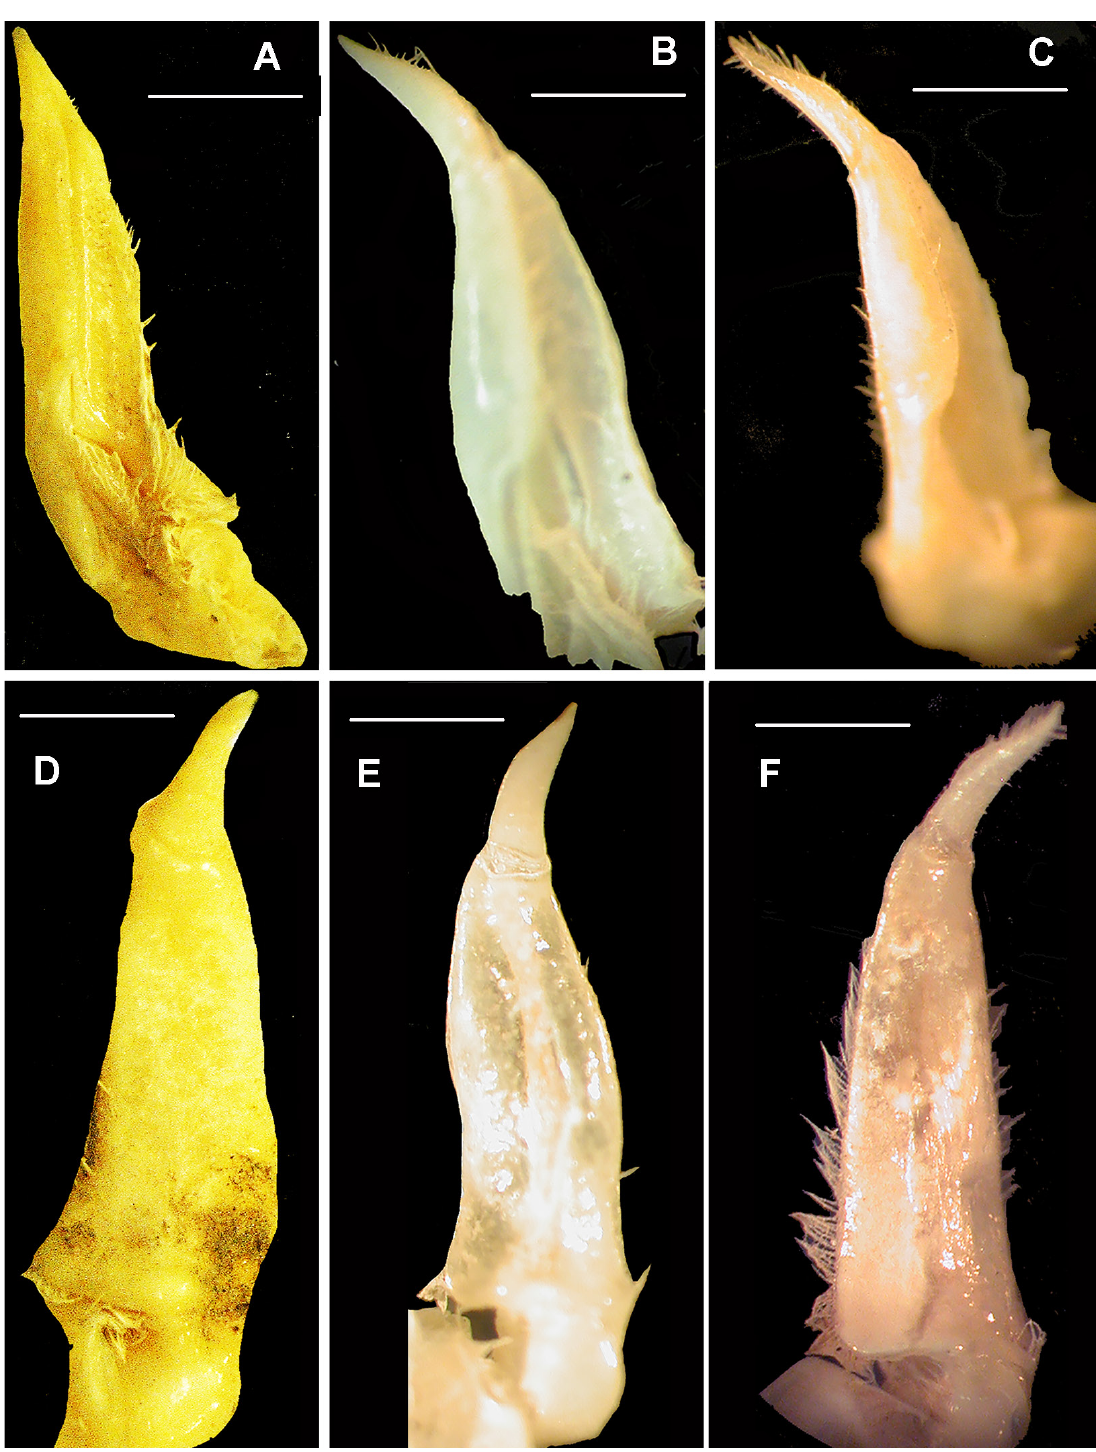
Fig. 6. G1, ventral view (A–C) and dorsal view (D–F). A, D . Potamonautes entebbe sp. nov., holotype, adult ♂, CW 35 mm, from Entebbe, southern Uganda (NHMUK 1955.11.8.26). – B, E . P. busungwe sp. nov., holotype, adult ♂, CW 21.5 mm, from Busungwe Island, Lake Victoria (NHMUK 2017.37). – C, F . P. kantsyore sp. nov., holotype, adult ♂, CW 16.8 mm, from Kantsyore Island in the Kagera River, southern Uganda (NHMUK 2017.29). Scale bars: A, D = 2.3 mm; B, E = 3.1 mm; C, F = 3.3